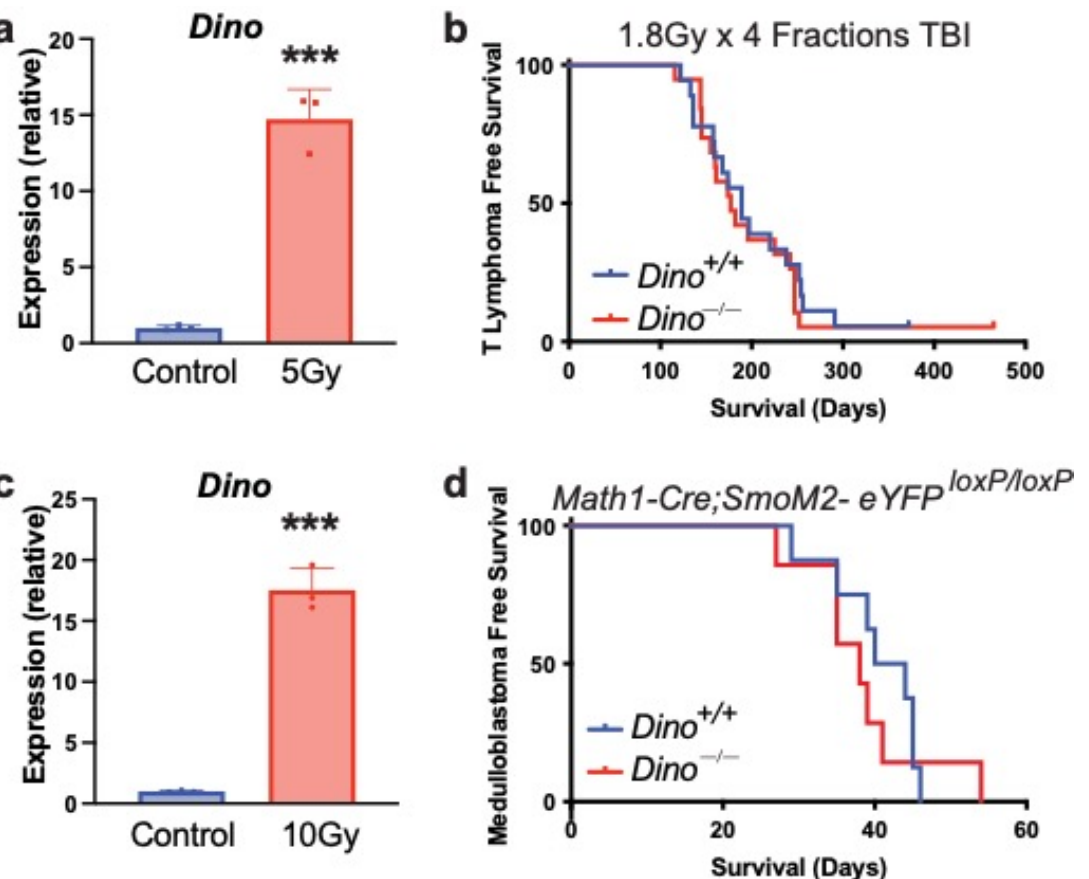
Figure 3. Loss of Dino has no effect on tumor-free survival in mouse models of T cell lymphoma or Shh-driven medulloblastoma. ( a ) Dino is induced in adult thymus 6 h after 5 Gy TBI. n = 3, *** p < 0.001, t -test. ( b ) Kaplan–Meier curve indicates no significant difference in survival between WT and Dino mutant mice post fractionated irradiation. Median thymic lymphoma-free survival Dino +/+ 189 days ( n = 18), Dino − / − 177 days ( n = 18), p = 0.6, Log-Rank test. ( c ) Dino is induced in postnatal day 16 cerebellum 6 h after 10 Gy irradiation. N = 3, *** p < 0.001, t -test. ( d ) Kaplan–Meier curve indicates no significant difference in survival between WT and Dino mutant mice in a Math1-Cre; SmoM2- eYFP loxP/loxP background. Median medulloblastoma-free survival Dino +/+ 42 days ( n = 8), Dino − / − 38 days ( n = 7). p = 0.62, Log-Rank test.